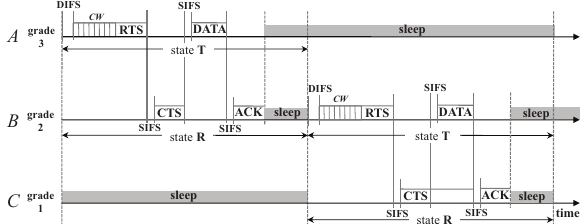
Figure 2. CW-RTS/CTS: node A has node B ’s RID in its Next Hop table, so its RTS is dedicated for node B and node B replies with CTS without